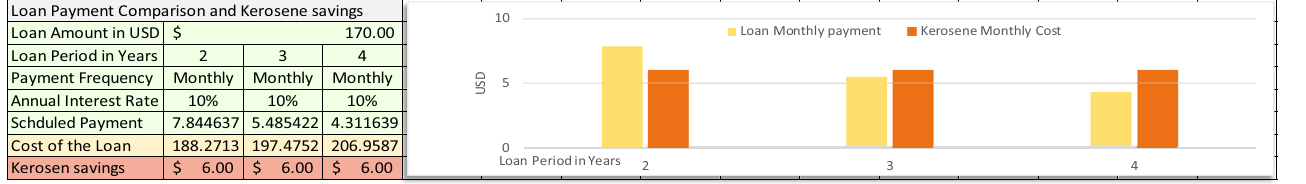
Fig. 6. Microloan monthly payments